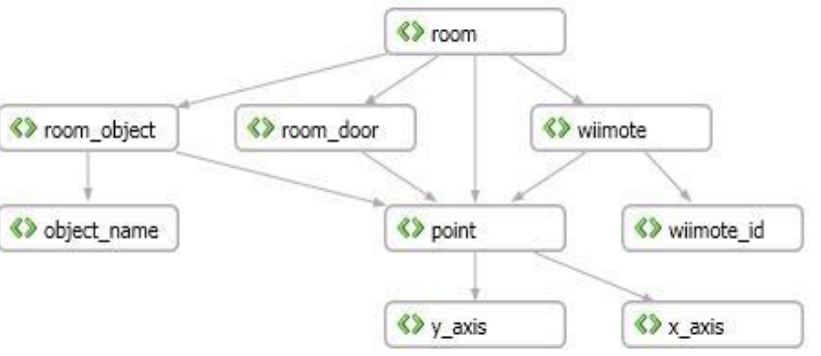
Figure 7. Tree structure representing the XML file that describes a